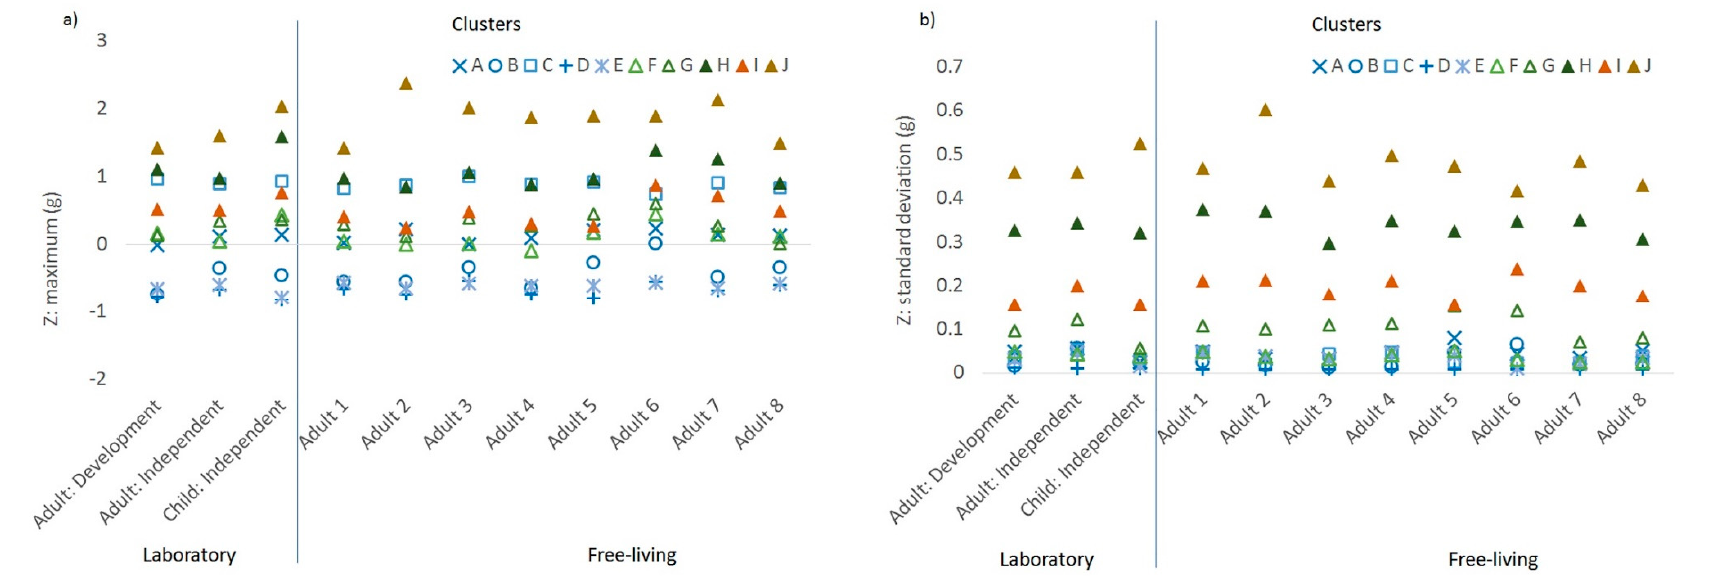
Figure 2. Characteristics of the acceleration features with the highest loadings by cluster and by sample, time domain: ( a ) maximum acceleration in the Z -axis and ( b ) standard deviation of acceleration in the Z